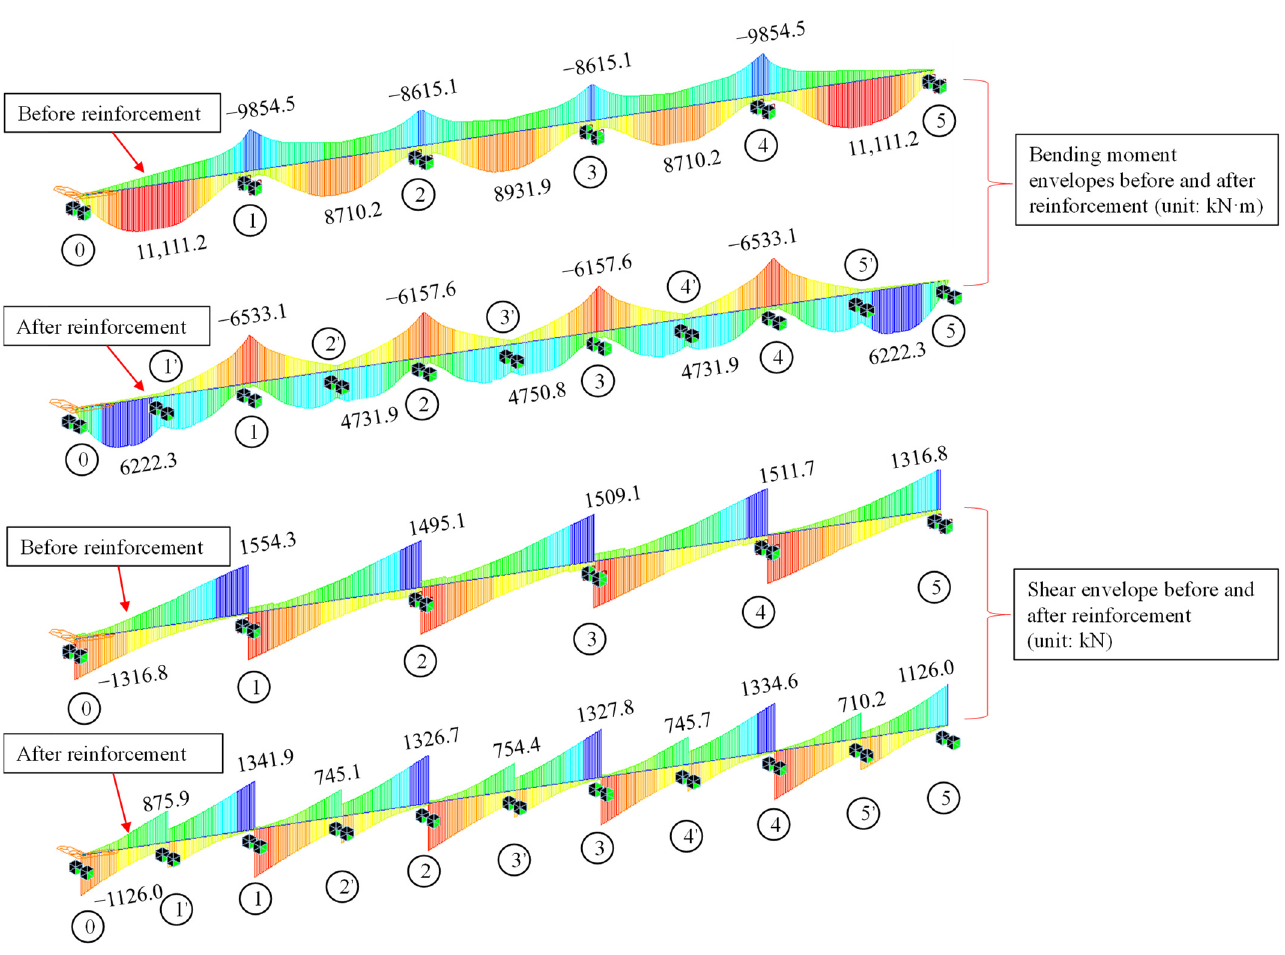
Figure 9. Bending moment and shear envelopes before and after reinforcement.